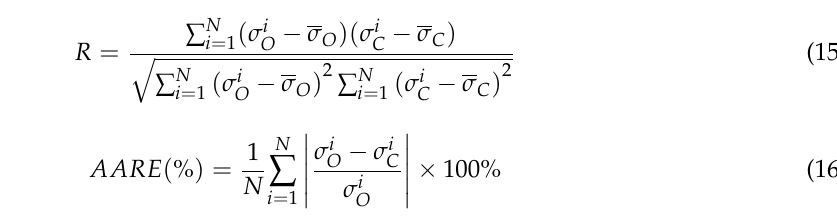
Table 4. The obtained values of correlation coefficient ( R ) and average absolute relative error ( AARE ) for the established models.